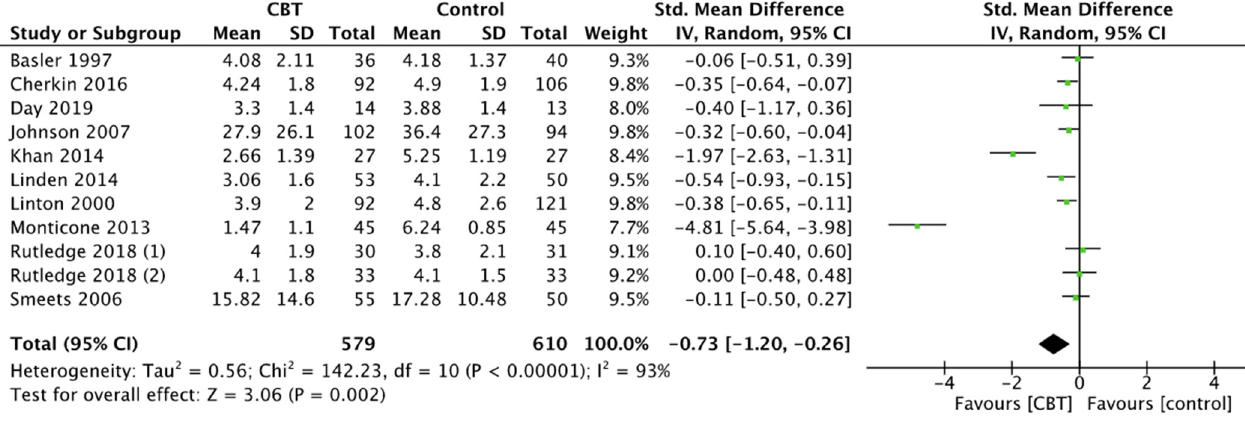
Figure 2. Pain: CBT versus control.